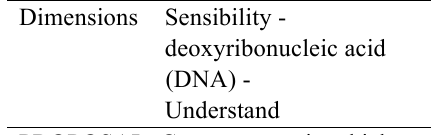
Table 1. Mediation example for the creation of main quests and side quests